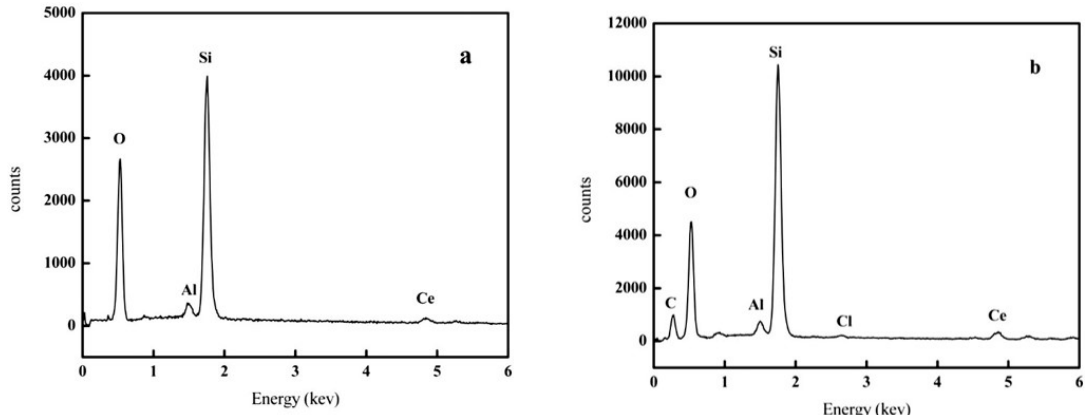
Figure 22. Energy dispersive X-ray spectroscopy spectrum of CeO 2 /HZSM-5 ( a ) before and ( b ) after plasma catalytic reaction. Reprinted from Reference [125], with permission from Elsevier.